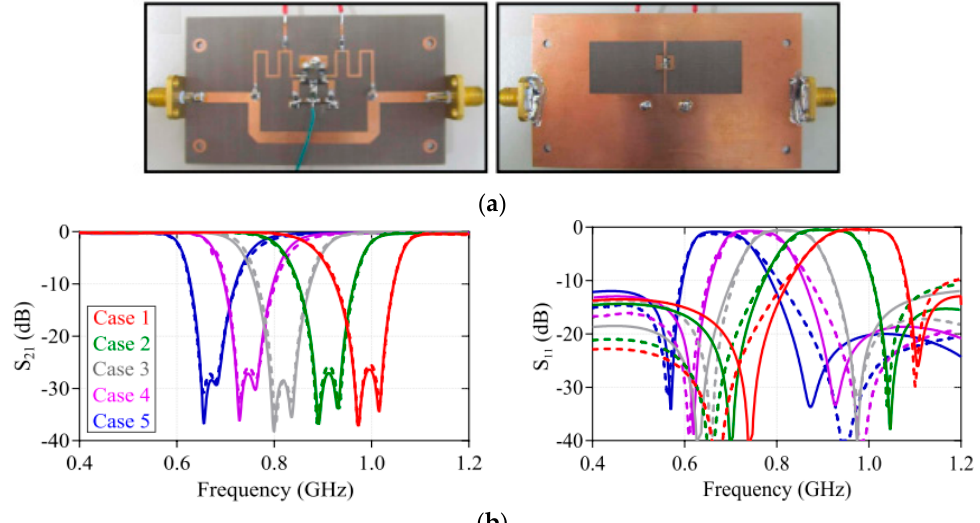
Figure 4. The reconfigurable filter reproduced from [32]. 2020, IEEE: ( a ) prototype structure; ( b ) S-parameter performance.